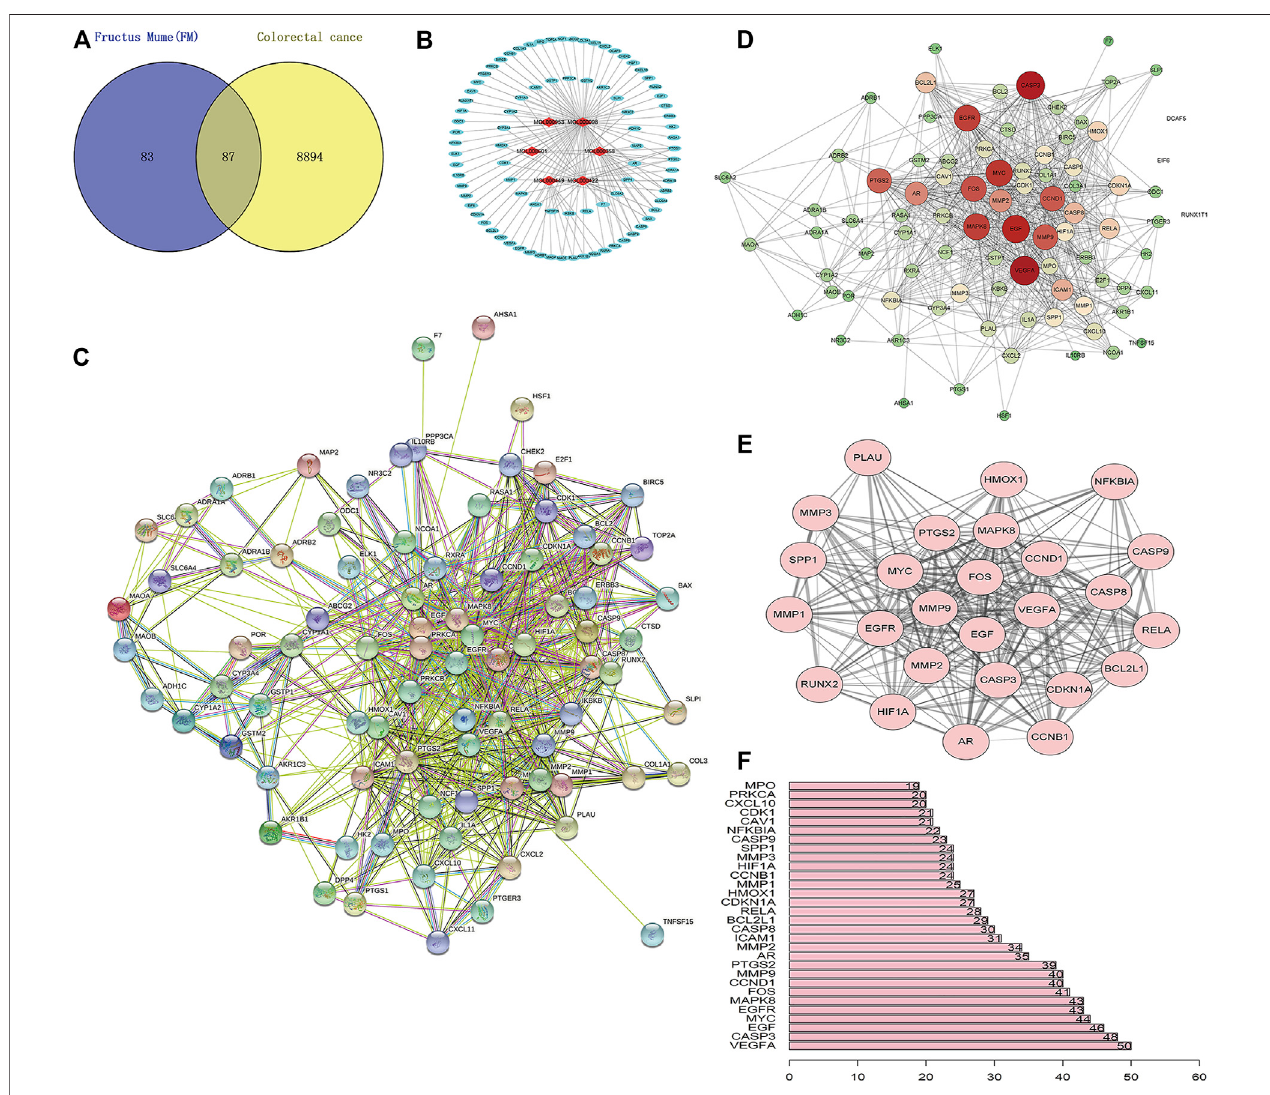
FIGURE 3 | Construction of PM active ingredient — target gene network in colorectal cancer and screening of key molecules. (A) Venn diagrams of drug and disease targets. After screening and repeating, blue represents only the drug target, yellow represents only the disease target, and the middle color represents the intersection of the two targets. (B) Construction of drug active components — target gene network. (C) Target protein interaction network analysis (PPI) in STRING database. (D) Targetproteininteractionnetworkanalysis(PPI)inCytoscape3.8.2software. (E) Thetop25geneswithhigherexpressiondifferenceswereobtained by PPI screening. (F) Protein interaction relationship histogram of PM